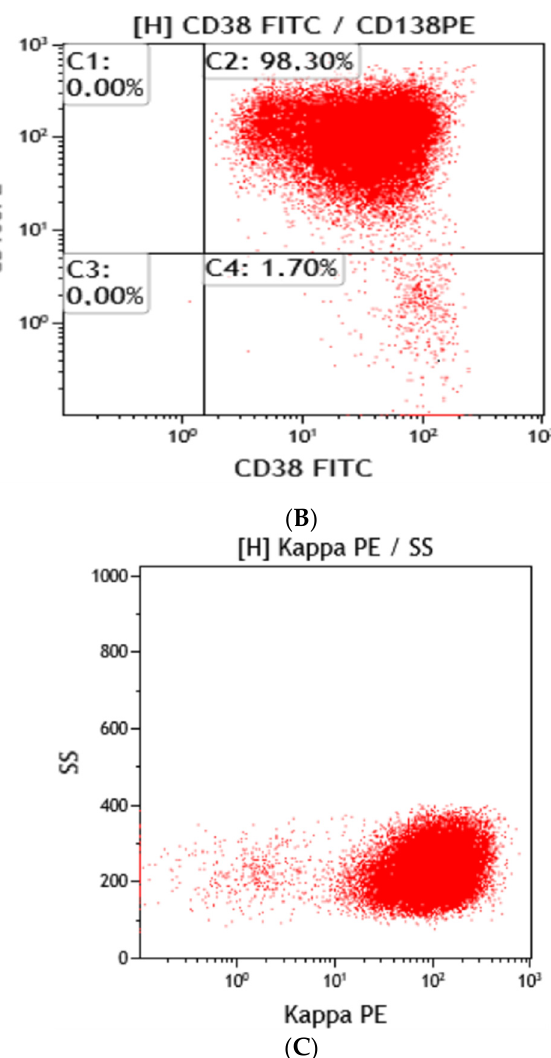
Figure 3. ( A ) CSF sample. Plazma cell population (red color). ( B ) CSF sample. Plazma cell population CD38++ CD138++. ( C ) CSF sample. Monoclonal plazma cell population Kappa++.